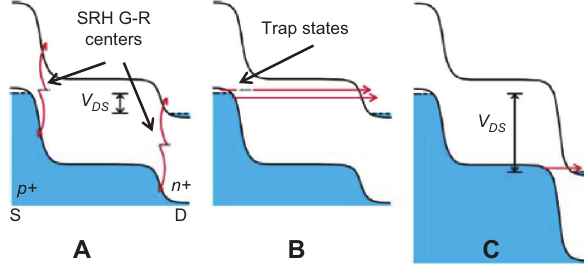
Figure 5 Energy band diagrams showing leakage mechanisms of n-type TFET at OFF-state: (A) Shockley-Read-Hall generation in the source (S) and drain (D) regions; (B) direct and defect-assisted tun- neling from source to drain; and (C) ambipolar transportation with hole injection from drain to channel. Reprinted from Ref. [22], with permission, from